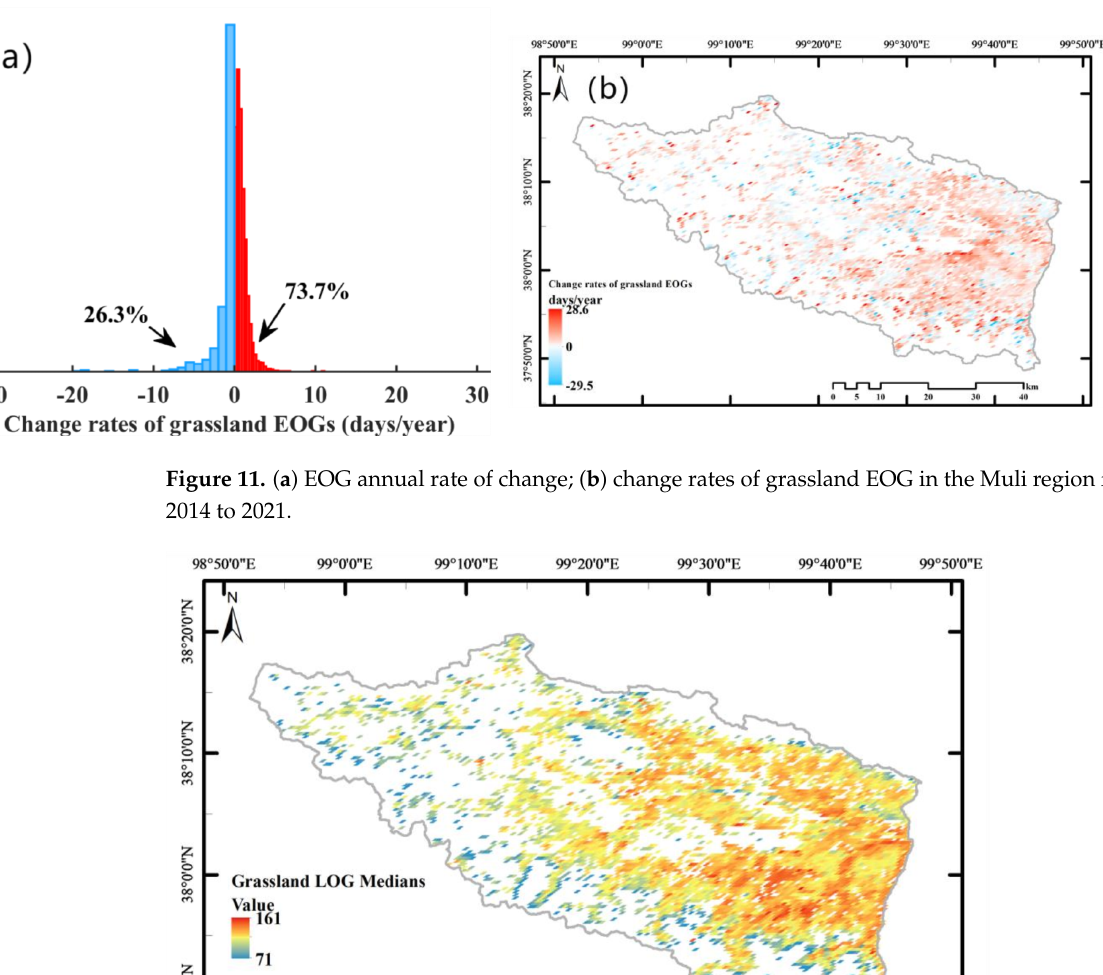
Figure 10. EOG average in the Muli region from 2014 to 2021.